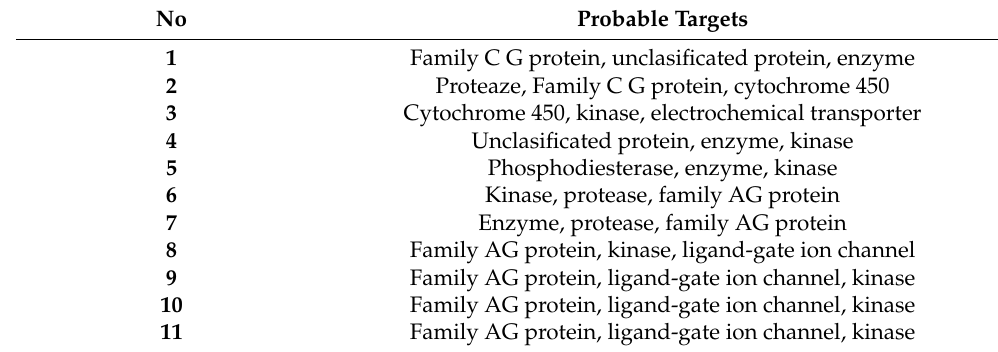
Table 8. Probable target classes of 1,9-dipyridothiazines 1 – 11 Table 8 . Probable target classes of 1,9-dipyridothiazines 1 – 11 [26].